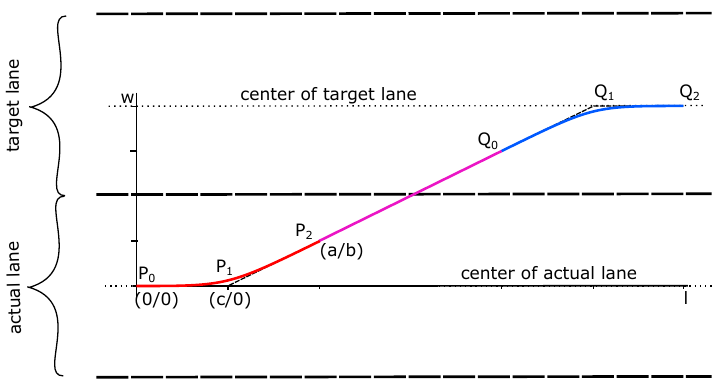
Figure 4. Lane change with two quadratic Bézier curves and a linear segment. The Bézier curves provide a smooth transition to initiate and finish the lane change, while the straight segment can be shortened or extended during the lane change maneuver according to the width of the target